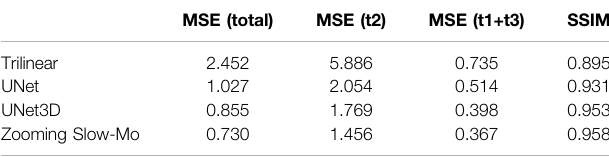
TABLE 1 | Test set evaluation